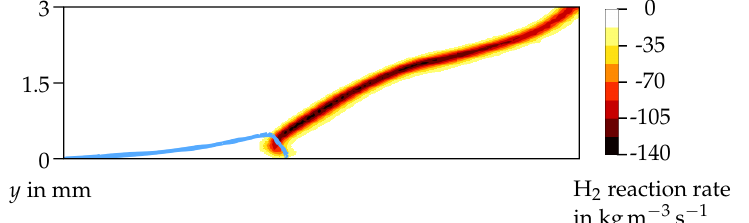
Figure 12. Hydrogen reaction rate and flame separation during flashback. Blue line represents the u = 0 isosurface.